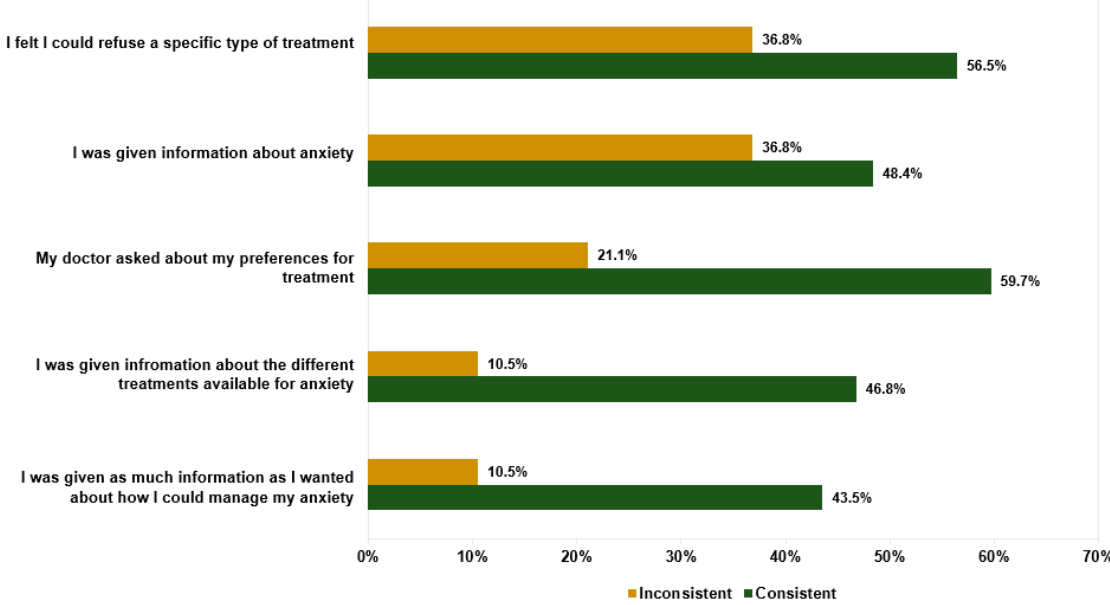
Figure 3. Comparison of agreement ratings with treatment items between participants who received a treatment consistent with their preferences (“consistent”, n = 62) and those who did not (“inconsistent”, n = 19).